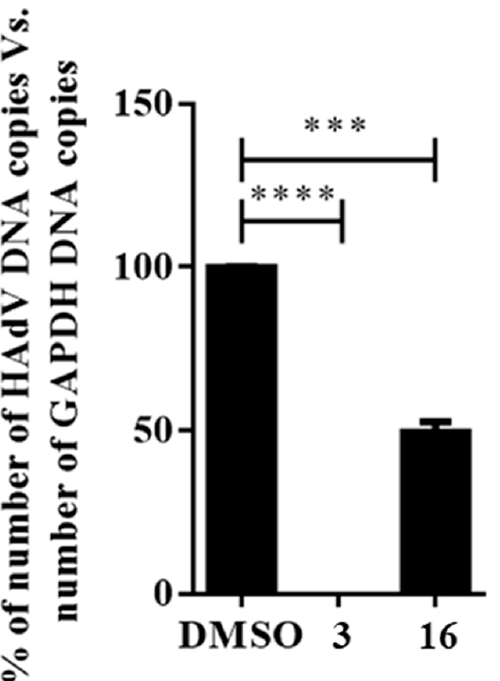
Figure 3. Effect of compound 16 on the HAdV DNA replication. Concentration of niclosamide (3) was 5 µ M and 10-fold IC 50 concentration obtained in the plaque assay for compound 16 . Bars represent means ± SD of triplicate samples. *** p ≤ 0.001, **** p ≤ 0.0001.